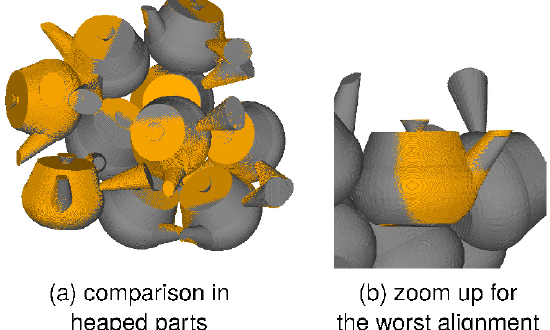
Fig. 5 Evaluation of rigid transformations obtained by our subgraph matching. (a) The teapots transformed by our method (colored by yellow) are overlaid with the ground truth (colored by gray). (b) The teapot with the largest misalignment is zoomed